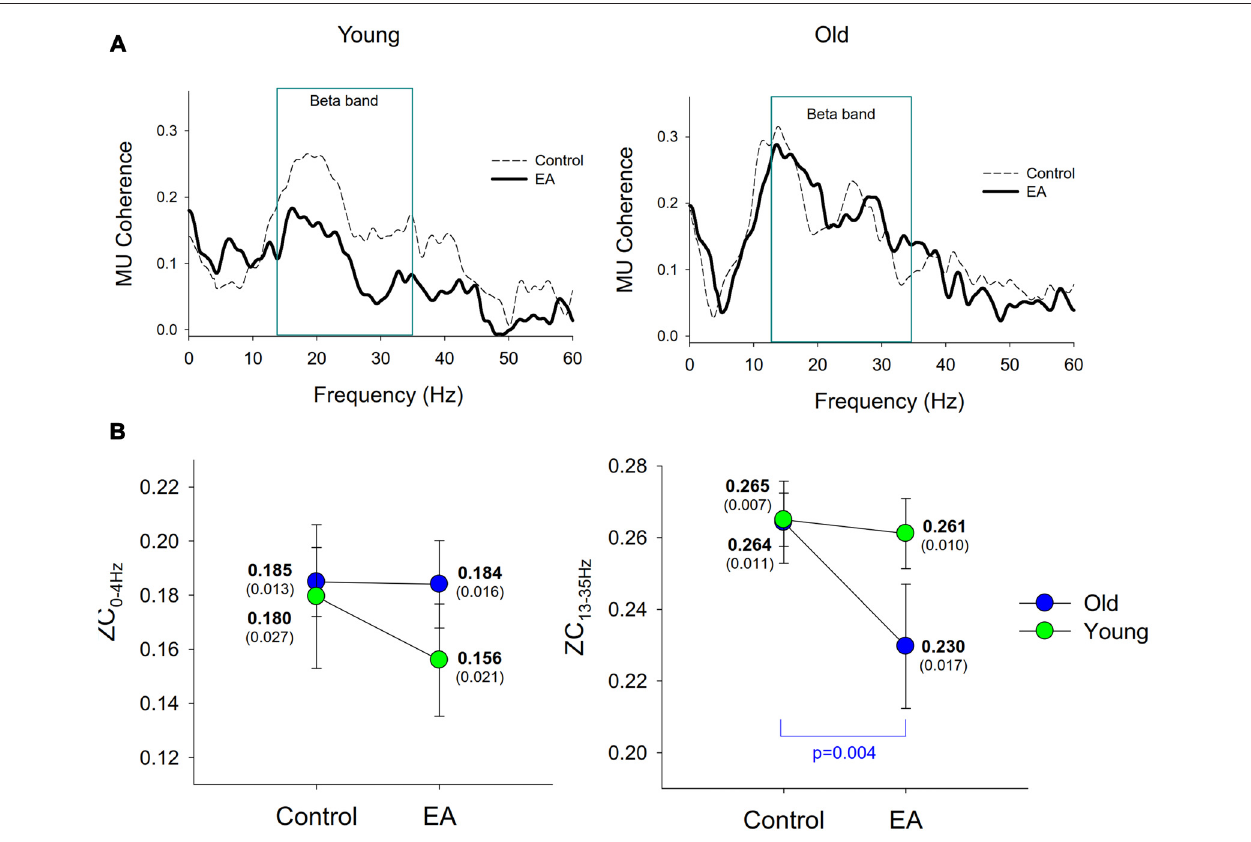
FIGURE 5 | Discharge coherence among motor units. (A) The contrast of the pooled motor unit coherence between the control and EA conditions for the young and old groups. (B) The contrast of means and standard errors of the coherence peaks in the 0–4 Hz (ZC 0–4 Hz ) and 13–35 Hz (ZC 13–35 Hz ) bands between the control and EA conditions for the two